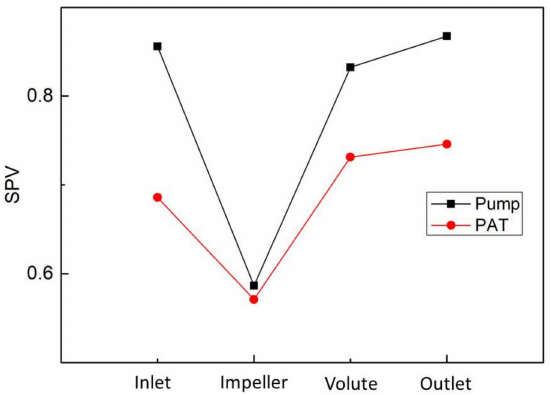
Figure 7. SPV variation in different parts of the pump and PAT.